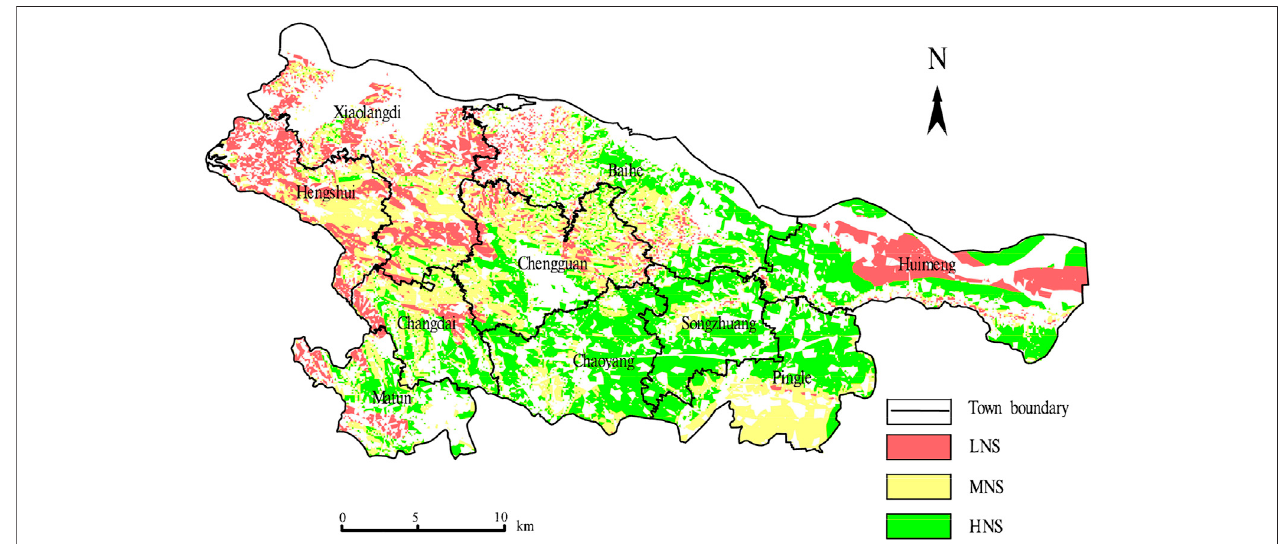
FIGURE 3 | Map of spatial distribution of natural suitability of farmland in Mengjin